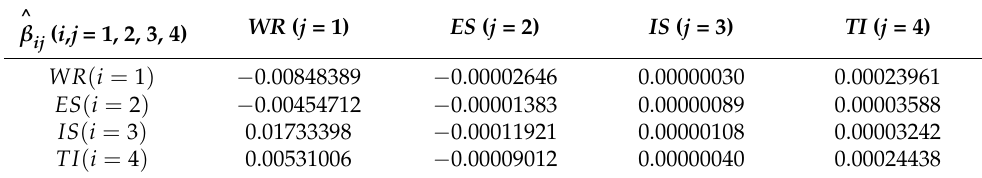
Table 5. Related parameters of GLV model in Hebei